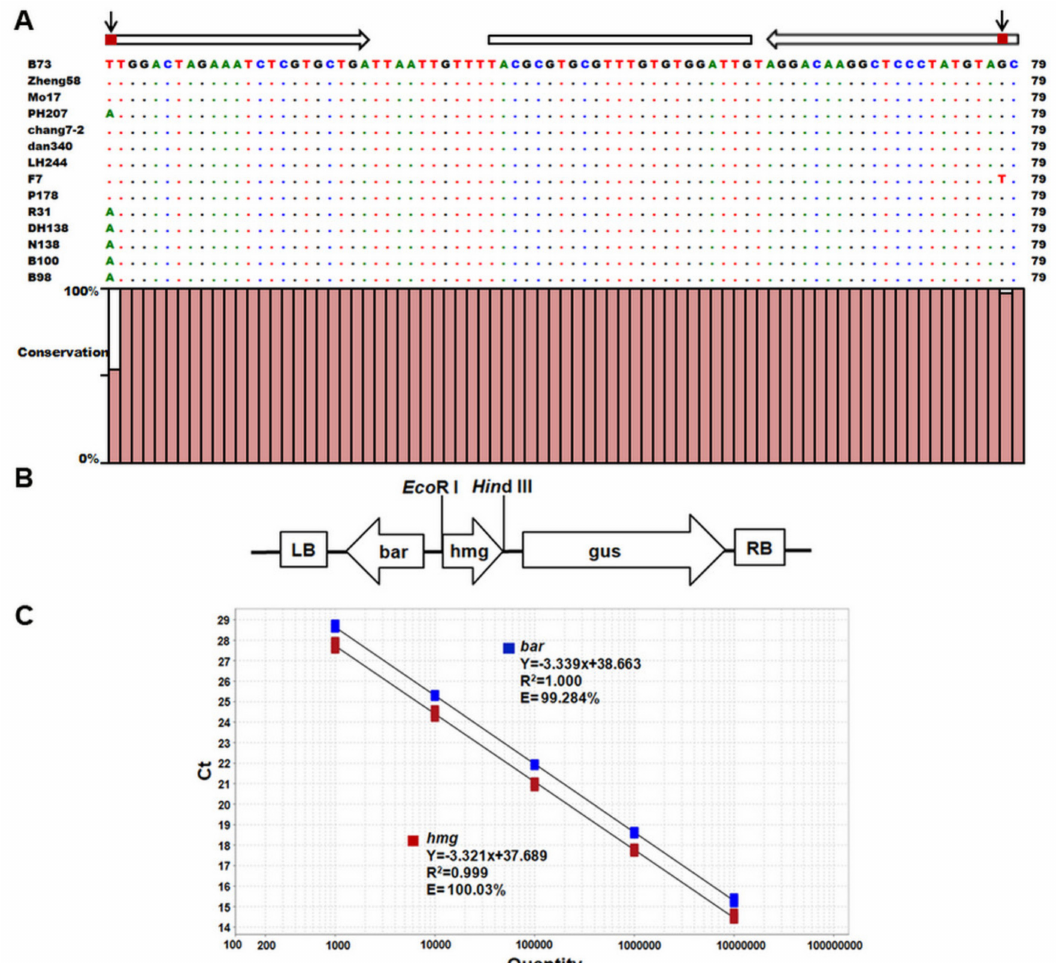
Figure 1. Development of universal TaqMan copy number assays in 384-well format for high-throughput screening. ( A ) Detected SNPs within amplified target DNA of hmg gene. Identical nucleotides are indicated by dots. White arrows and lines represent primers and probe attachment sites of hmg assay. Observed single-nucleotide polymorphism is shown in red boxes on white arrows. SNP of T to A was found at the first nucleotide from the 5 (cid:48) end in the forward primer in maize line PH207, and another of G to T at the second nucleotide from the 5 (cid:48) end in the reverse primer in maize line F7. No sequence variation was found in the probe. ( B ) Schematic diagram of pCAMBIA3301-ZmHMG. LB, left border; bar , phospinothricin acetyl transferase gene; hmg , fragment of maize endogenous gene hmg ; gus , β -glucuronidase; RB, right border. Position of the Eco R I and Hin dIII restriction site is indicated above the T-DNA insert. ( C ) TaqMan assay efficiency for hmg and bar primer and probe sets. Five 10-fold serial dilutions of standard plasmid (1.0 × 10 7 to 1.0 × 10 3 copies/ µ L) were used in duplexed TaqMan copy number assays, as mentioned in Materials and Methods. Calculated Ct values were plotted against log of each concentration (copies/ µ L). Each sample was run in four replicates. Regression lines with their respective equations, correlation coefficient (R 2 ), and amplification efficiency (E) are presented for each